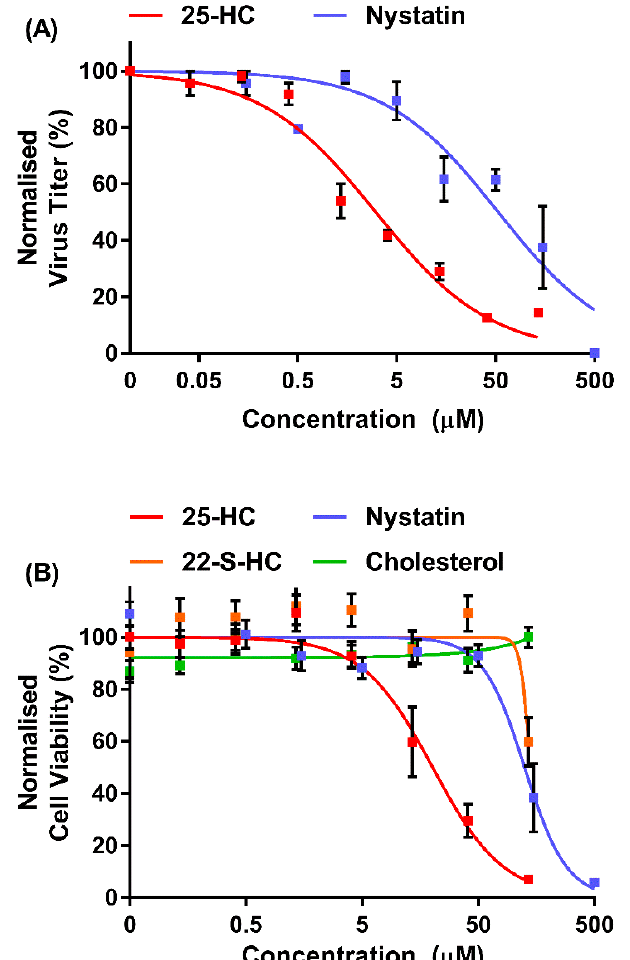
Figure 1. In vitro anti-viral activity of 25-HC on MNV replication. ( A ) RAW264.7 cells were infected with MNV at a multiplicity of infection (MOI) of approximately 0.05 TCID 50 /cell and were immediately treated with a range of concentrations of 25-HC (up to 135 µ M) or nystatin (up to 500 µ M) or the ethanol-only control. At regular intervals, replicate wells were harvested, the supernatant clarified by centrifugation and the virus titer determined by TCID 50 assay. Data show mean virus titer ( n = 2 ± SEM). ( B ) RAW264.7 cells were incubated with the indicated compounds for 72 h before the cell viability was measured by MTS assay. The ethanol (EtOH) or dimethyl sulphoxide (DMSO) solvents were used as controls. Data are expressed as mean percentage cell viability and normalized to untreated cells ( n = 3 ± SEM).